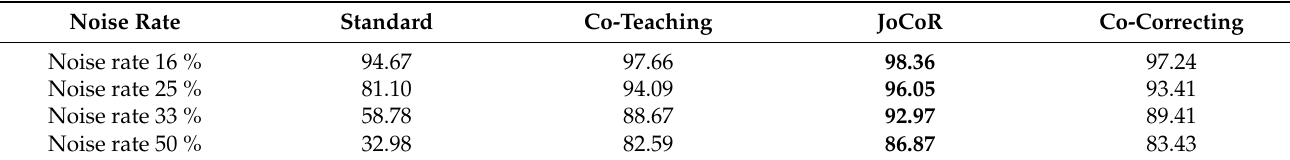
Table 3. The label precision of methods in Baselines with different noise